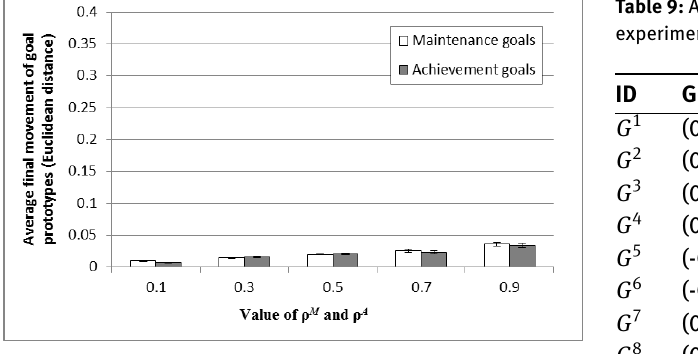
Figure 17: Expt 4: Impact of topology and ρ M and ρ A on convergence of cluster prototypes. Table 8: Maintenance goal prototypes generated in the first run of experiment 4 with ρ M = 0.9. Weights are rounded to 1 decimal place.